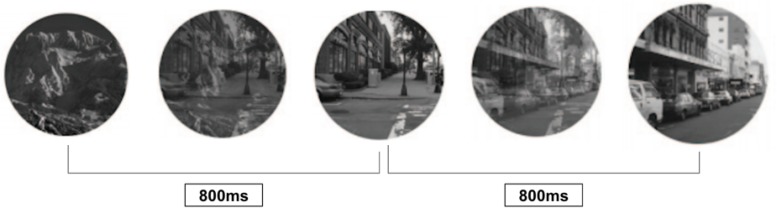
Illustration of gradCPT procedures, adapted from Fortenbaugh et al. (2015).